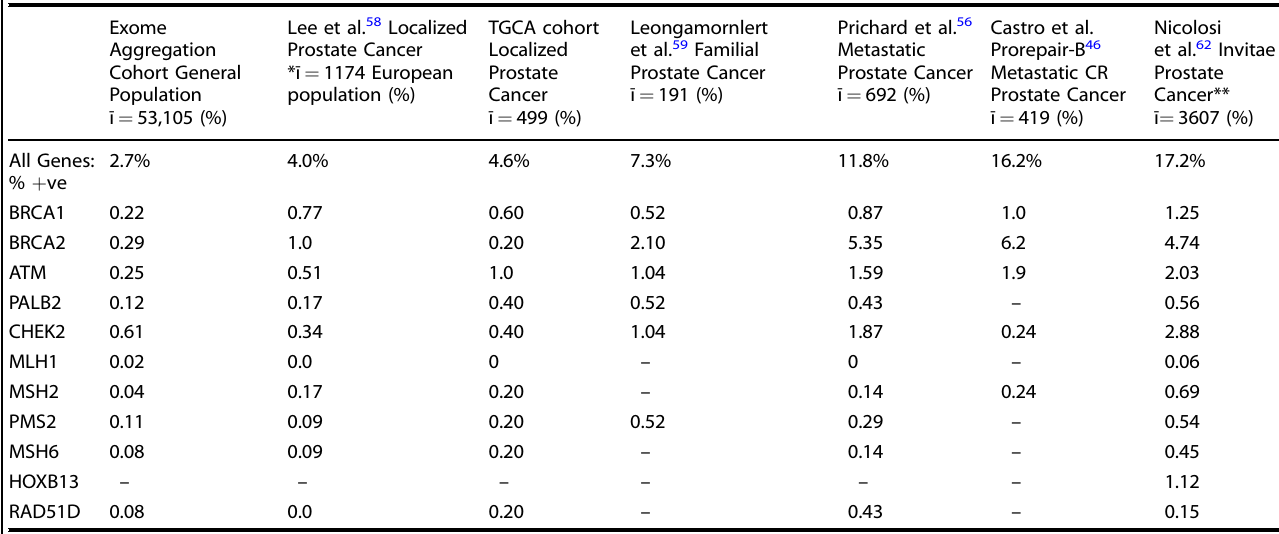
Table 1. Germline Mutation frequency in Men with Prostate Cancer and Population